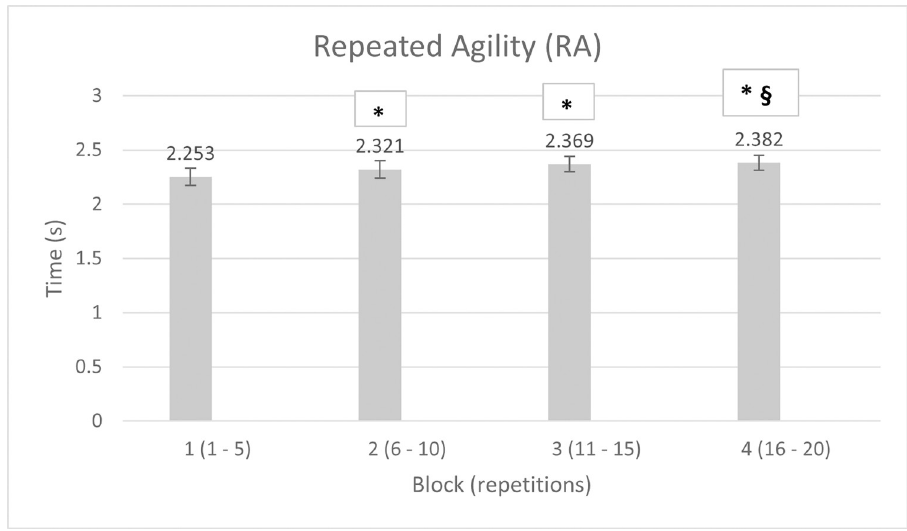
Fig 2. Mean times ± SD of RA blocks. � = different from block 1; § = different from block 2 (p < 0.05).